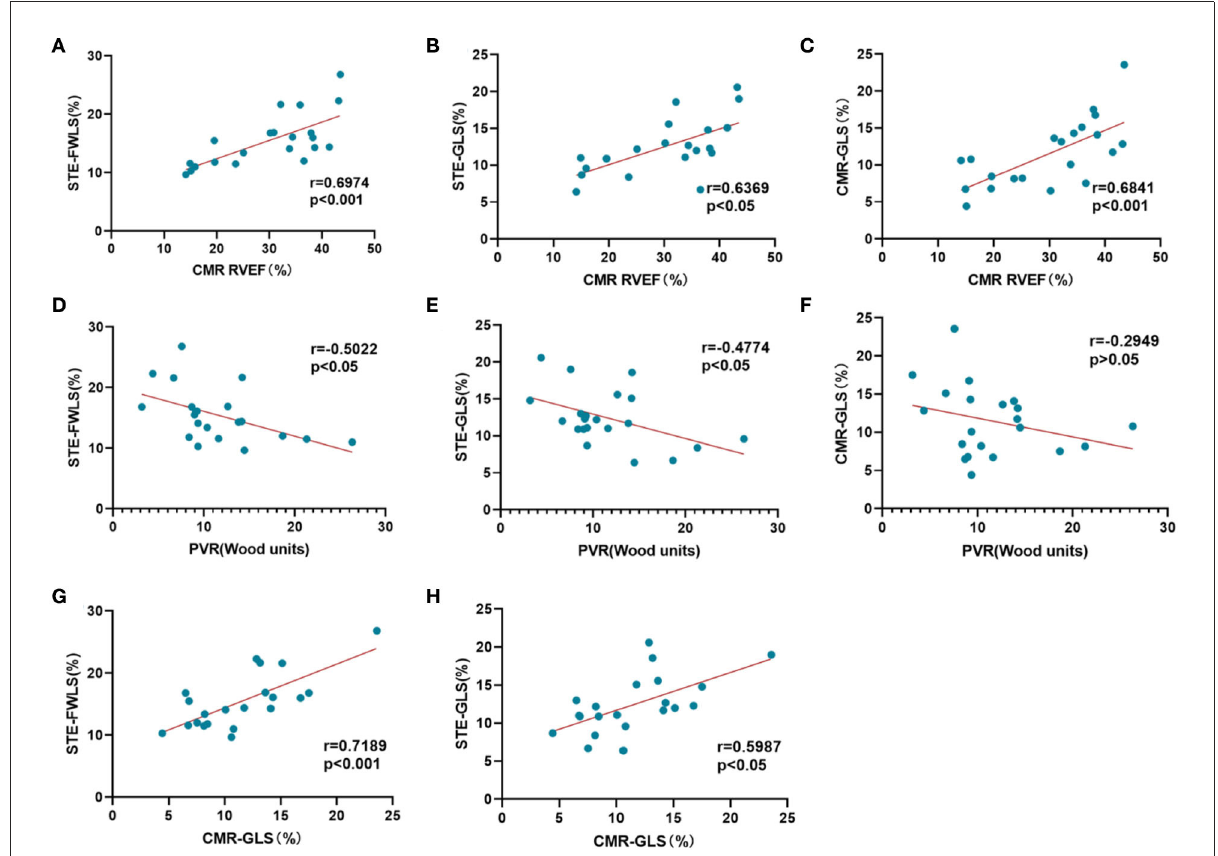
FIGURE2 Correlation analysis of myocardial strain evaluation. (A–C) Correlation of STE-RVFWLS, STE-RVGLS, and CMR-RVGLS with CMR-RVEF. (D–F) Correlation of STE-RVFWLS, STE-RVGLS, and CMR-RVGLS with PVR. (G,H) Correlation of STE-FWLS and STE-GLS with CMR-GLS.